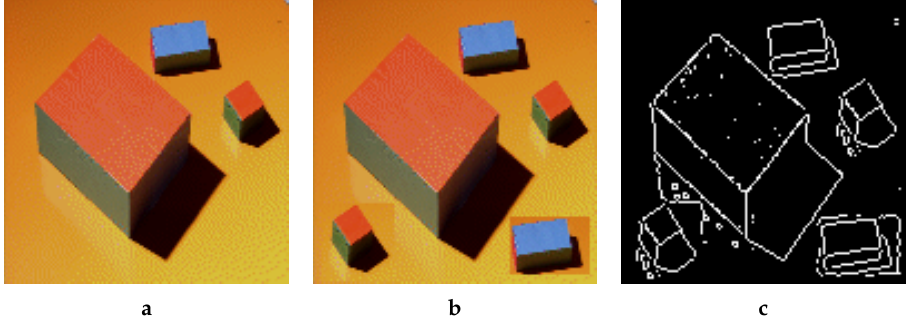
Figure 1. ( a ) Original, ( b ) Forged, ( c ) Sobel edge detection. Example of forged image in ( b ) with its tied Sobel edge detection. A simple copy of some parts in the original image may create rectangles in the resulting